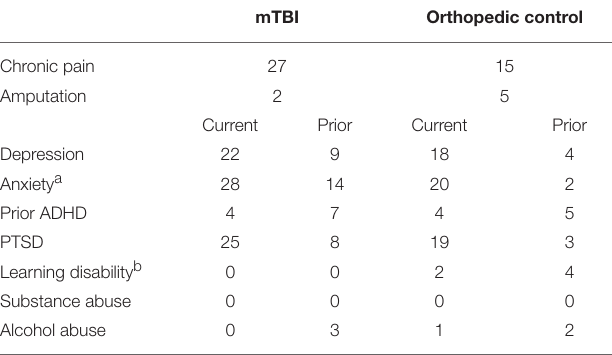
TABLE 2 | Numbers of participants having current comorbid conditions did not differ between groups; however, rates were slightly higher in the mTBI group.